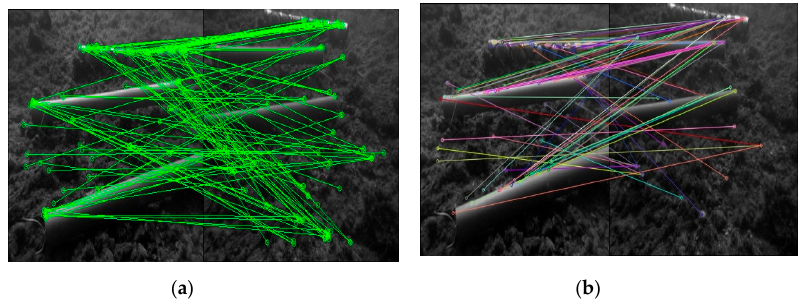
Figure 6. Comparisons on results of image matching (output from step (2)) for 110 points ( a ) Oriented FAST and Rotated BRIEF (ORB) and ( b ) proposed methods.